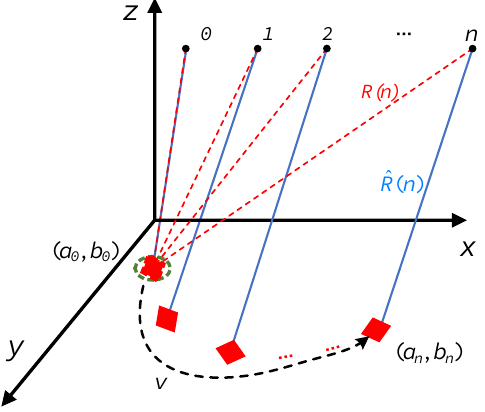
Figure 1. Geometry of synthetic aperture radar (SAR) system for observing a ground moving